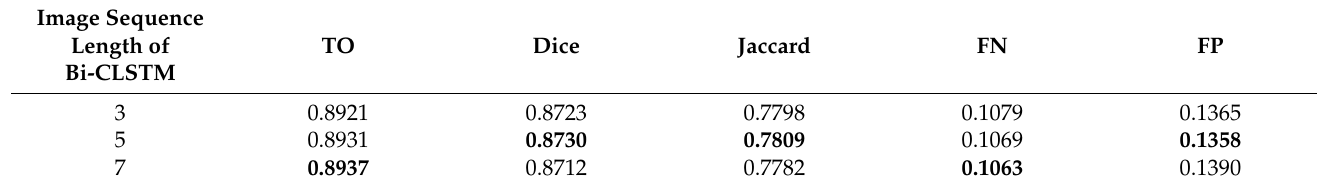
Table 3. Thrombus ROI segmentation results from three different lengths (N) of the image sequence for our Bi-CLSTM-based